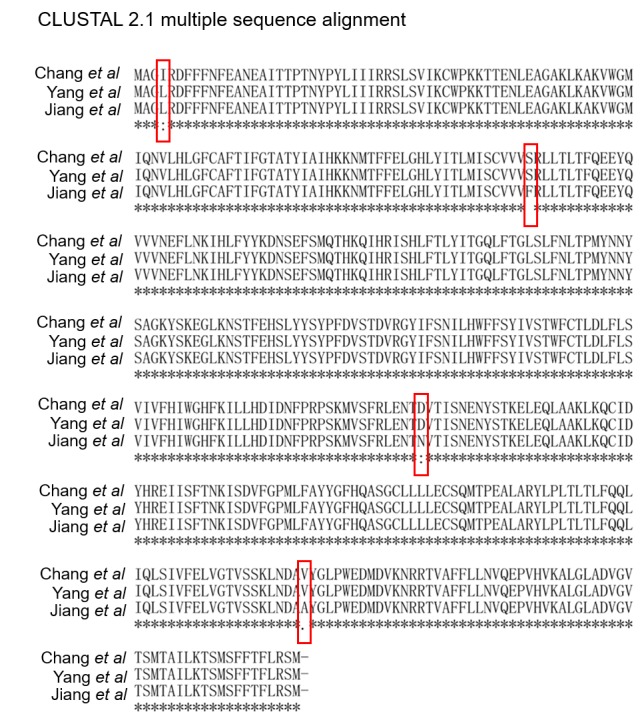
Alignment of amino acid sequences of HassOr14b in three studies: Yang et al.(this study), Jiang et al. (Jiang et al., 2014), and Chang et al. (Chang et al., 2016). The same residues are marked by ‘*’, and the different residues are marked by the red box ‘□’.